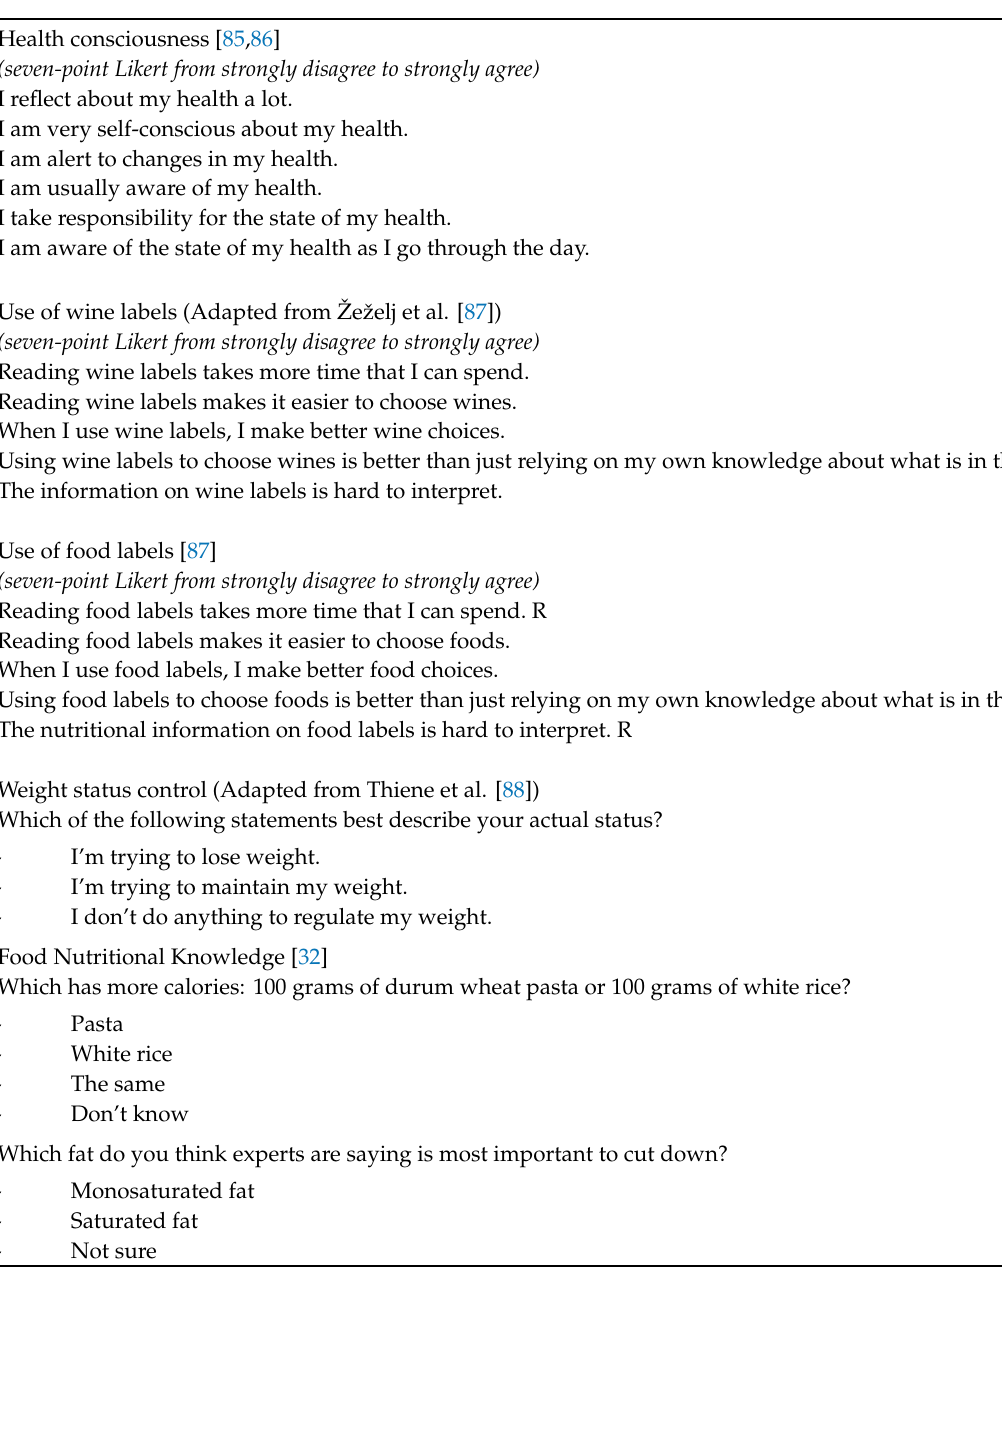
Table A1. Scales used to assess consumer attitudes and knowledge on health, food, and wine label use and wine drinking used in this